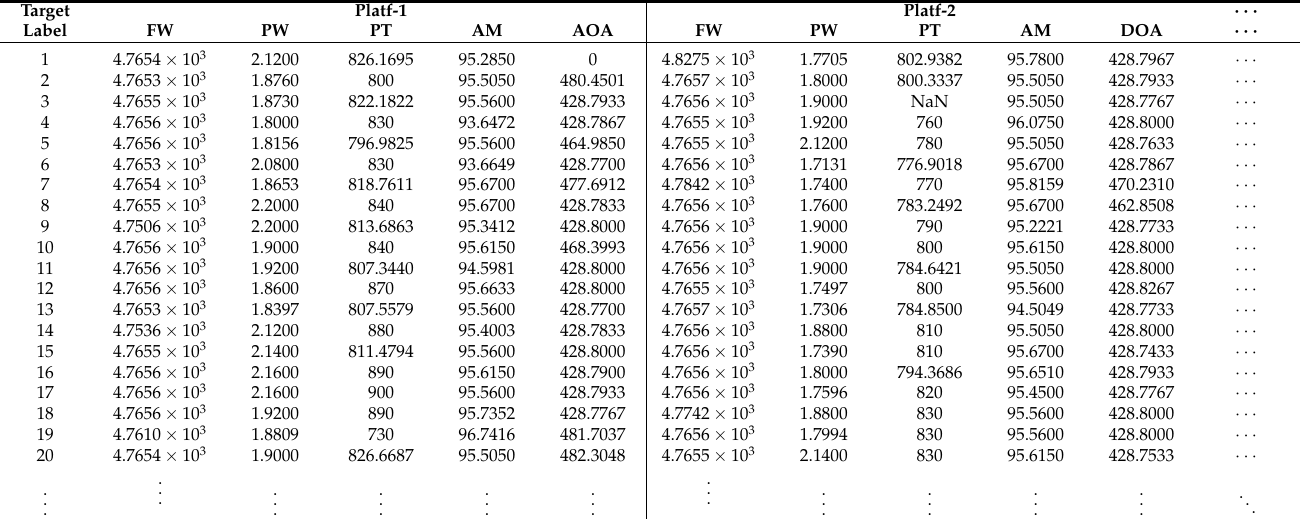
Table 10. Results recovered by Algorithm 2.